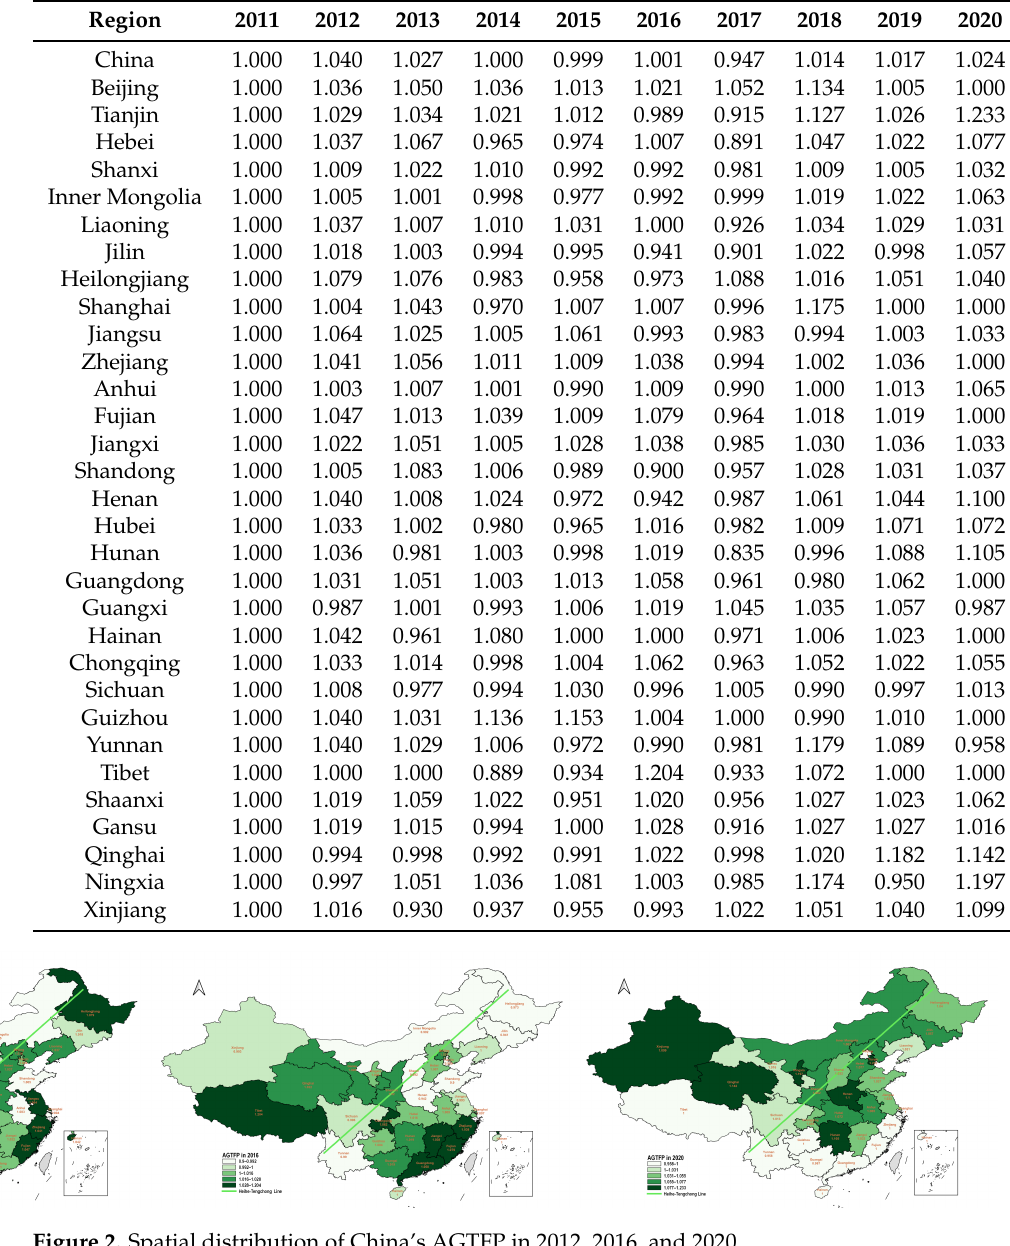
Table 4. The AGTFP index of China and 31 provinces (2011–2020).